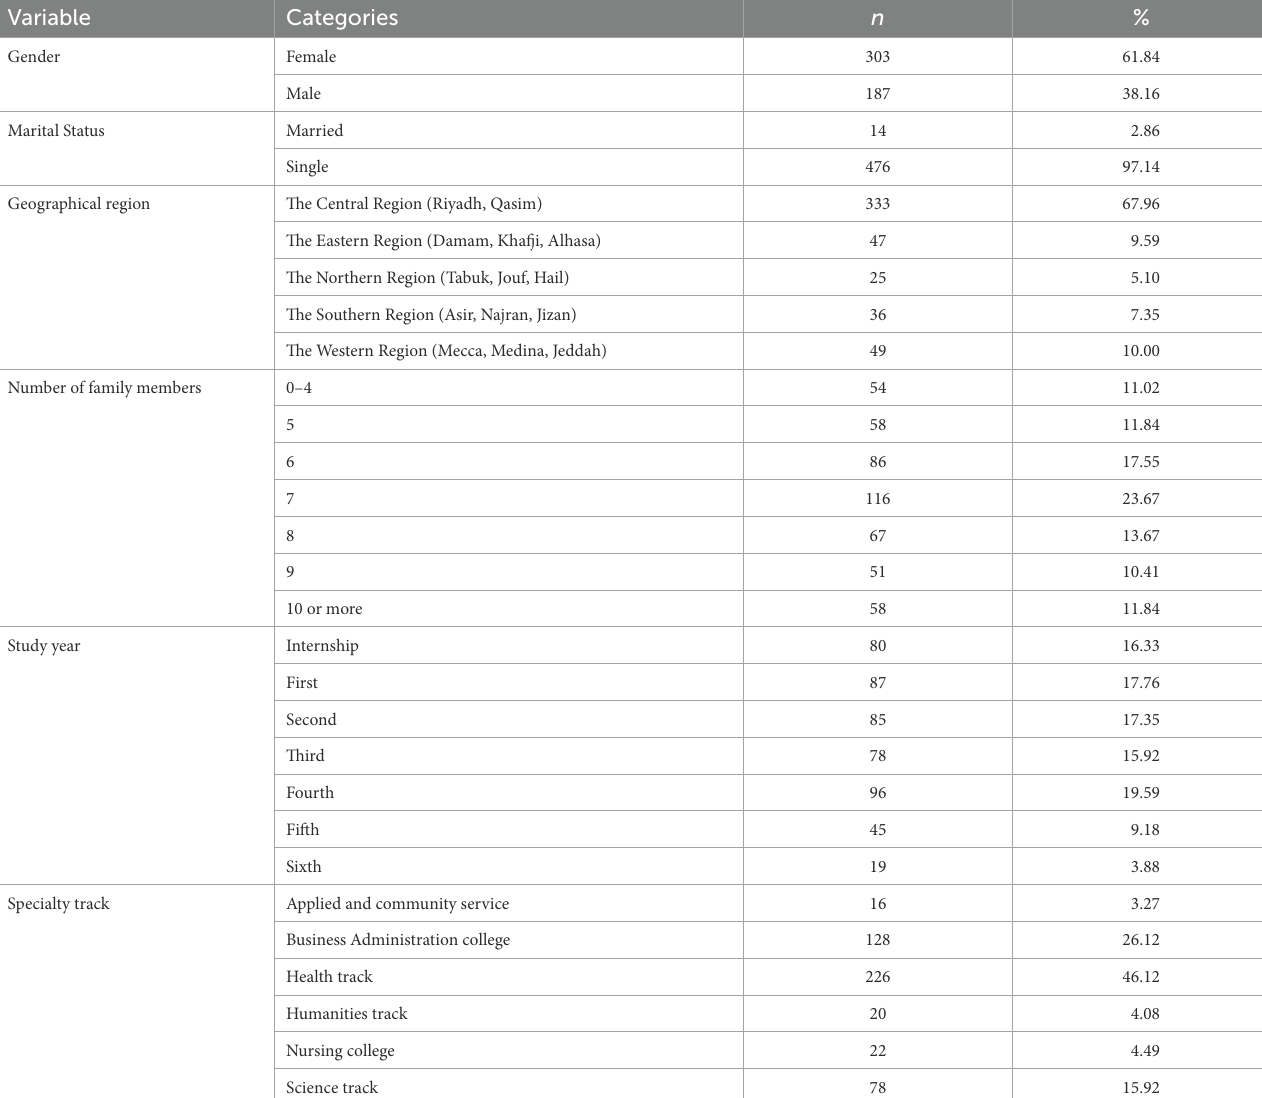
TABLE 1 Demographic characteristics of the sample ( N =